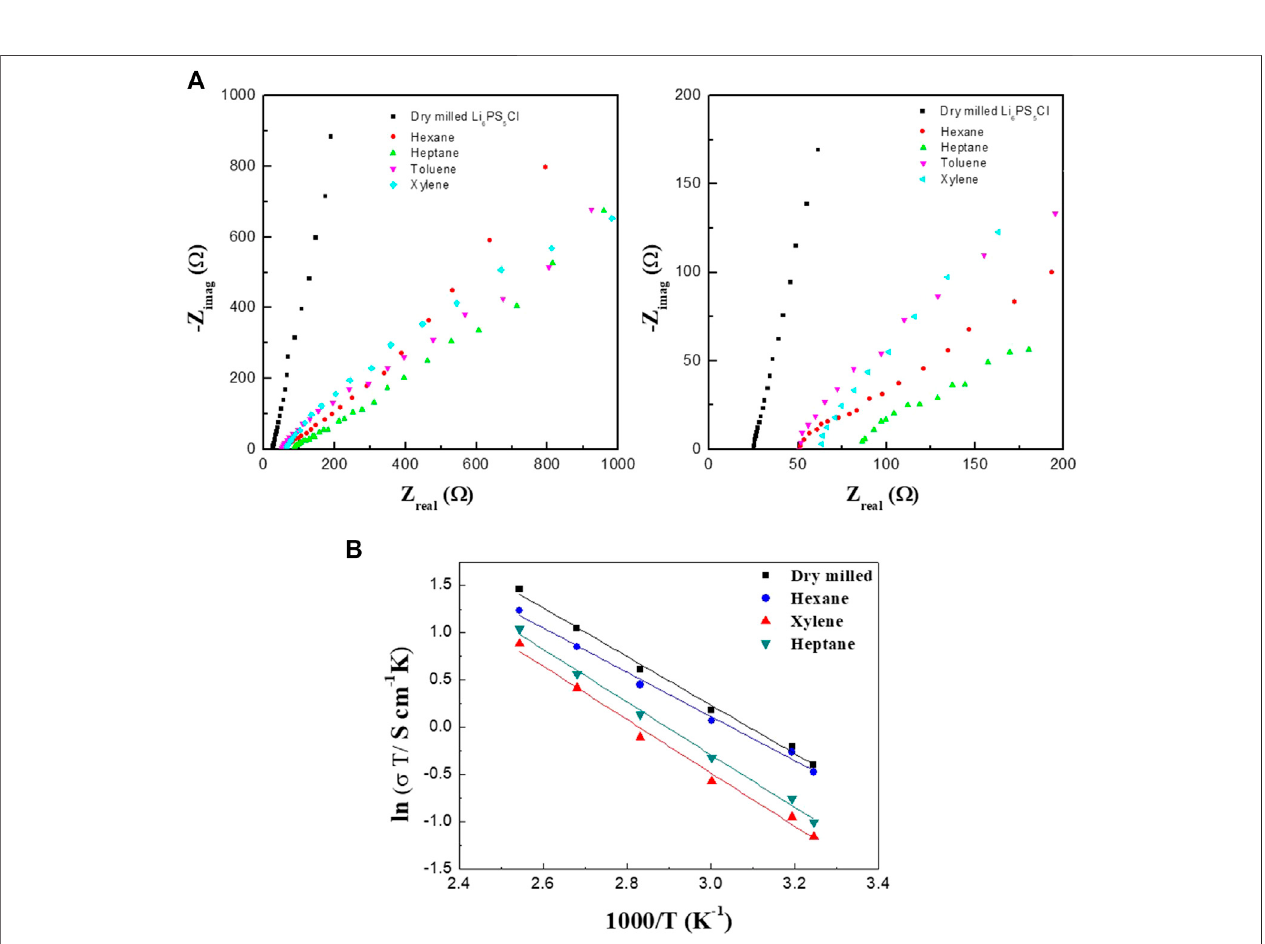
FIGURE 2 | Electrochemical impedance spectra (A) and Arrhenius conductivity plot (B) of symmetrical cells with wet-milled Li 6 PS 5 Cl electrolytes prepared using hexane, heptane, toluene, and xylene.